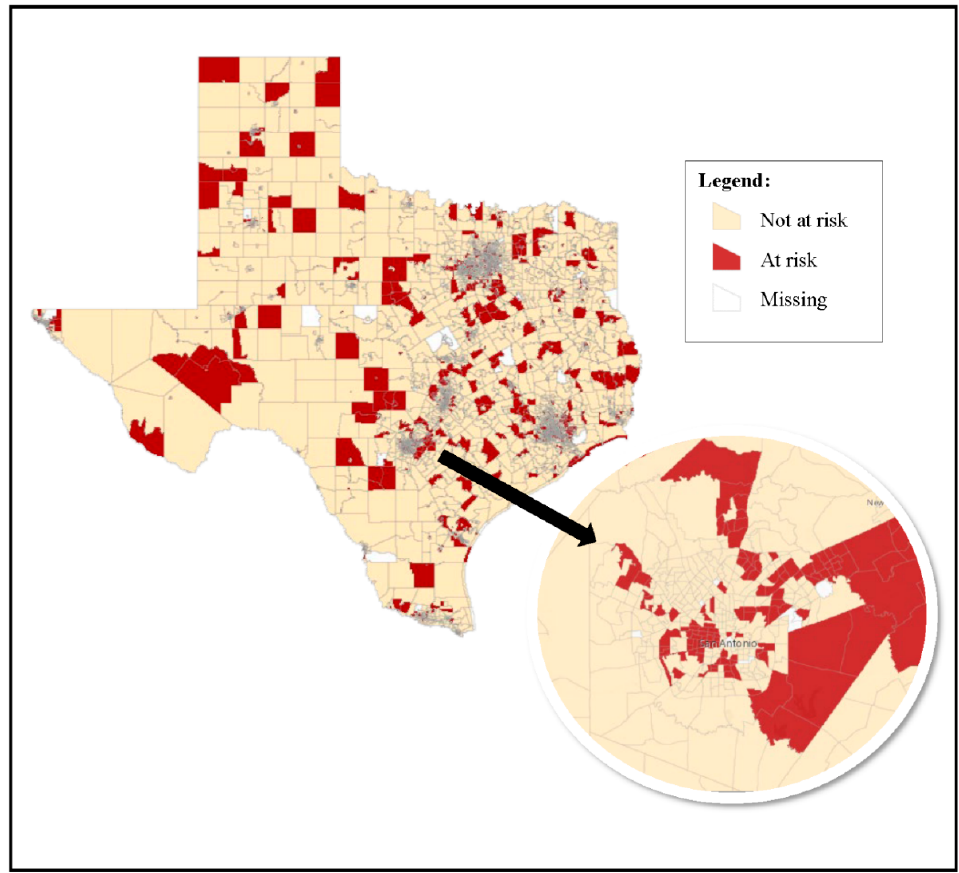
Figure 1. At-risk neighborhoods in Texas, 2010, census tracts, n = 5265 Note. At-risk neighborhoods were defined as census tracts with a median housing age < 1975 and a poverty level of ≥ 20%. Not-at-risk neighborhoods are census tracts with a median housing age of 1975+ and/or a poverty level <20%. Missing indicates census tracts where either median housing age or poverty level were unavailable. Source: American Community Survey, 2007–2011.